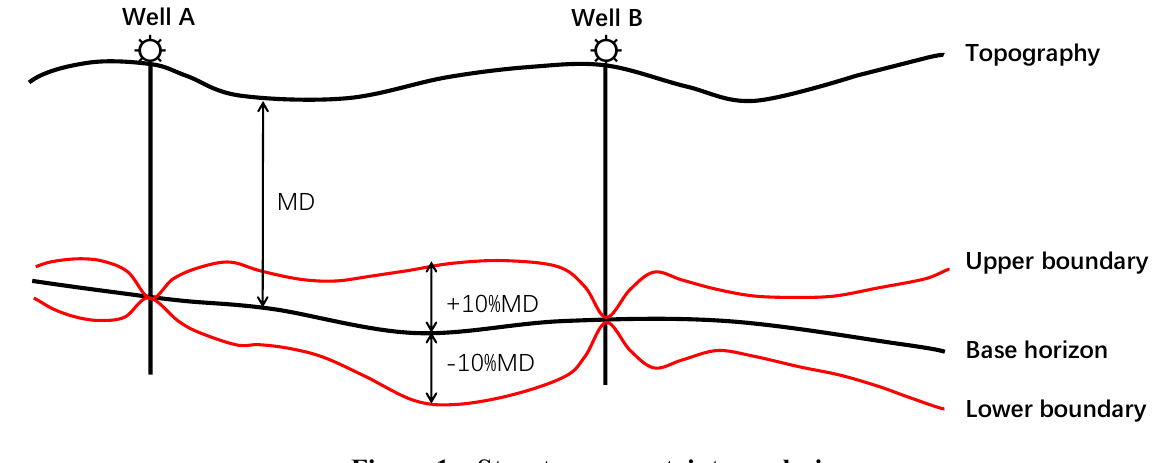
Figure 1—Structure uncertainty